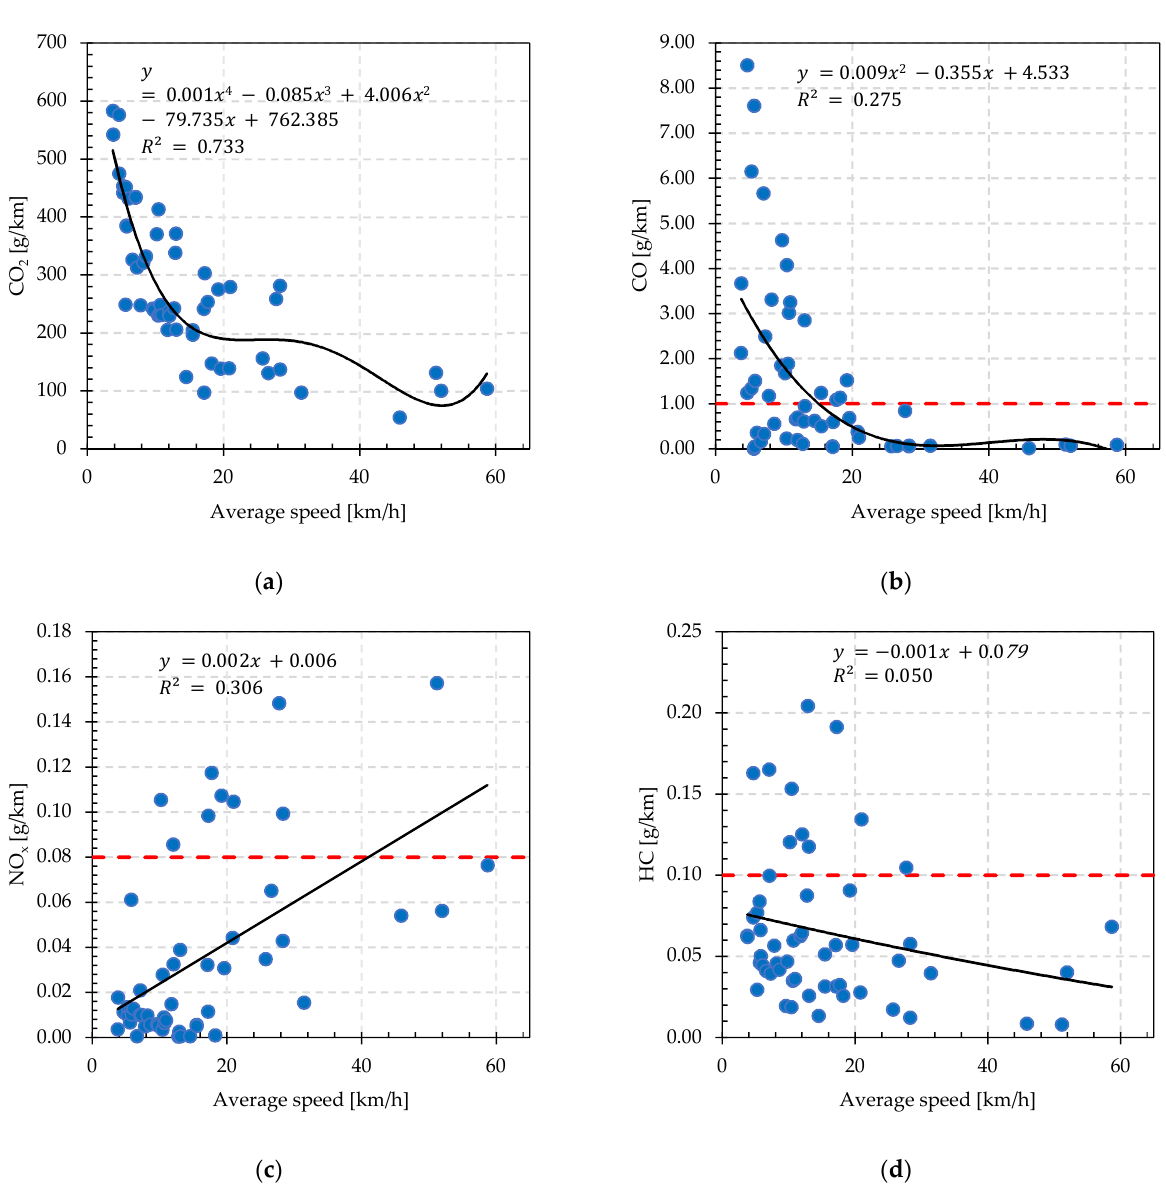
Figure 11. Correlation between the emission factors ( a ) CO 2 , ( b ) CO, ( c ) NO x , and ( d ) HC and the average speed of micro-trips for CV1. The dashed line indicates the Euro 4 standard limit.